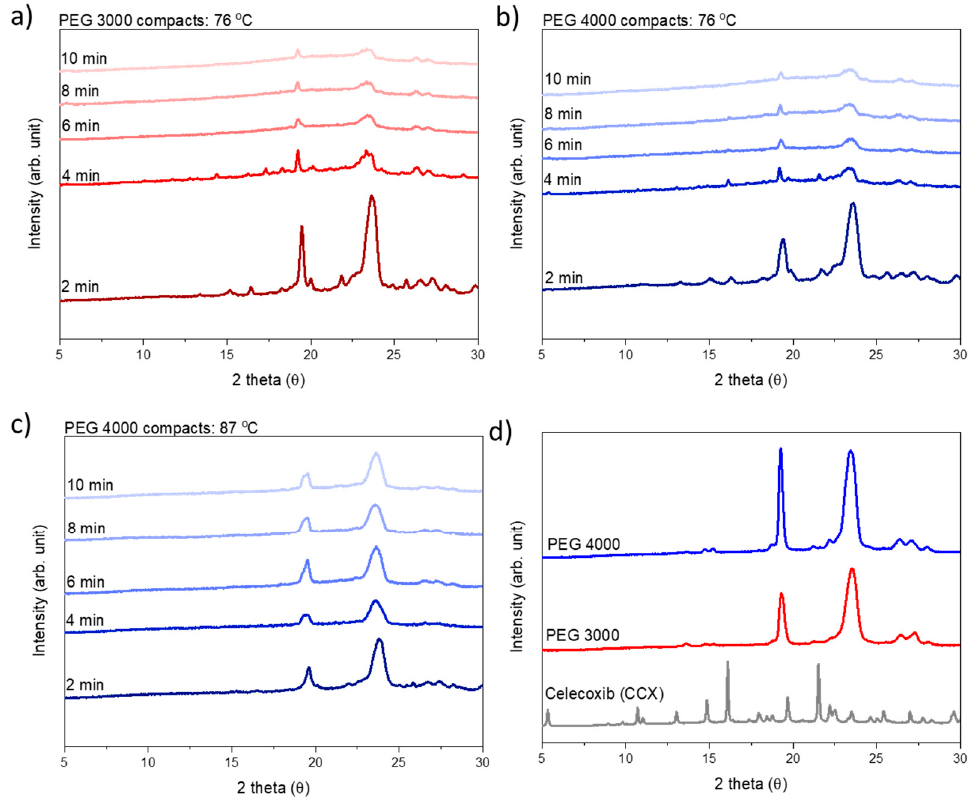
Figure 3. XRPD diffractograms for compacts exposed to microwave radiation for different times. ( a ) PEG 3000 at the target temperature of 76 °C; ( b ) PEG 4000 at the target temperature of 76 °C; ( c ) PEG 4000 at a target temperature of 87 °C and ( d ) pure substances for comparison. PEG 3000 compacts are colored red and PEG 4000 compacts are colored blue.